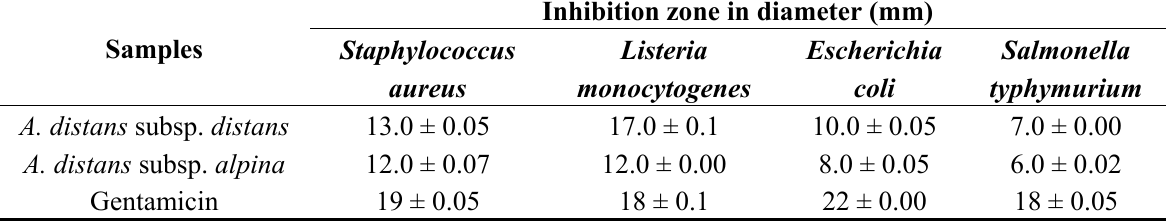
Table 5. Antibacterial activity (inhibition zone expressed in mm) a of two investigated extracts of A. distans